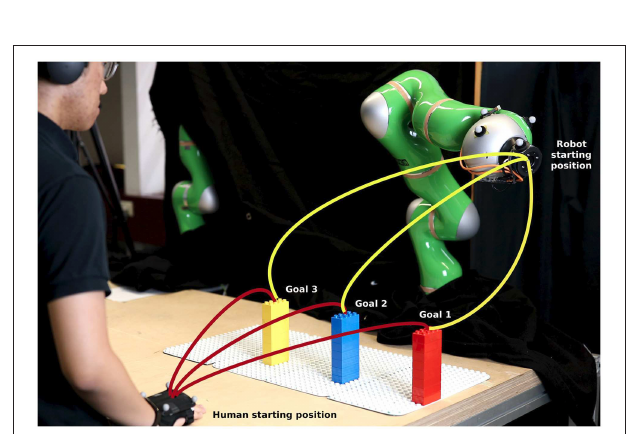
FIGURE 10 | Real experiment setup on a KUKA LWR 4+